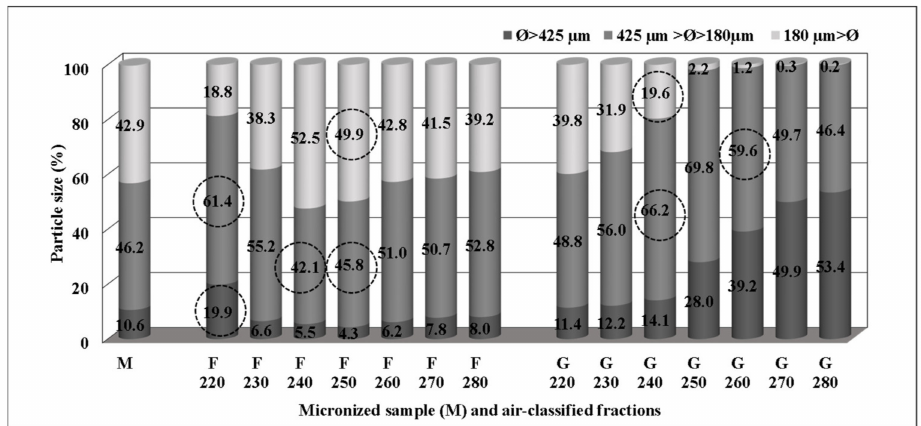
Figure 6. Mean percentages of particle size in micronized samples (M) and air-classified fractions (F and G types) of the mean of three cultivars. Circles highlight the fractions with significant differences ( p < 0.05) among cultivars (n =